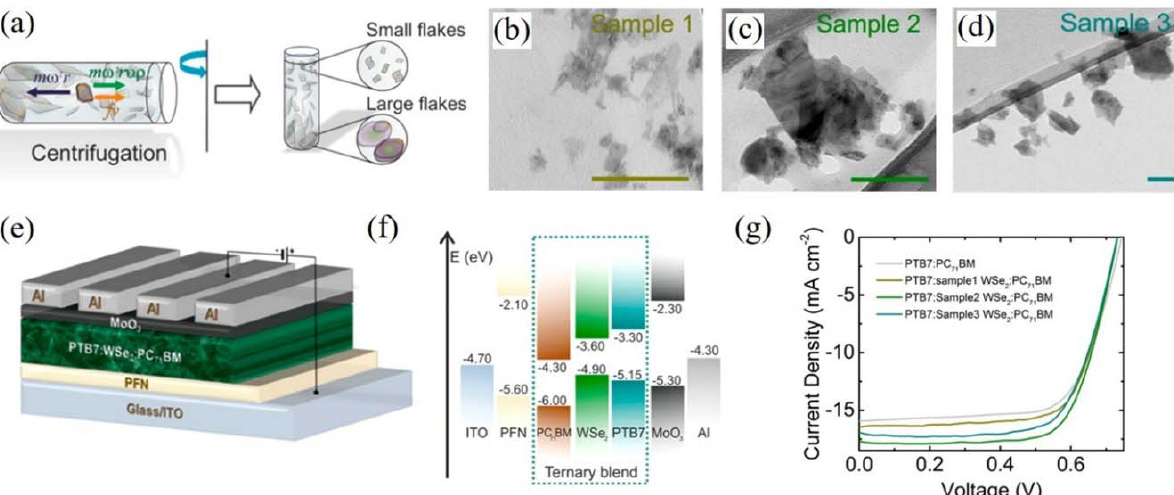
Figure 2. Schematic representation of ( a ) the fabrication of WSe 2 flakes by ultracentrifugation depended on SBS method and the separation of different sizes of WSe 2 flakes; TEM images of WSe 2 flakes with different area values of ( b ) ~70, ( c ) ~240 and ( d ) ~720nm 2 , respectively; ( e ) The device structure of ternary OSCs with incorporation of WSe 2 flakes in the active layer; ( f ) Schematic energy levels and ( g ) J-V curves of the OSCs based on PTB7:PC 71 BM. Reprinted with permission form [64]. Copyright 2017 American Chemical Society.